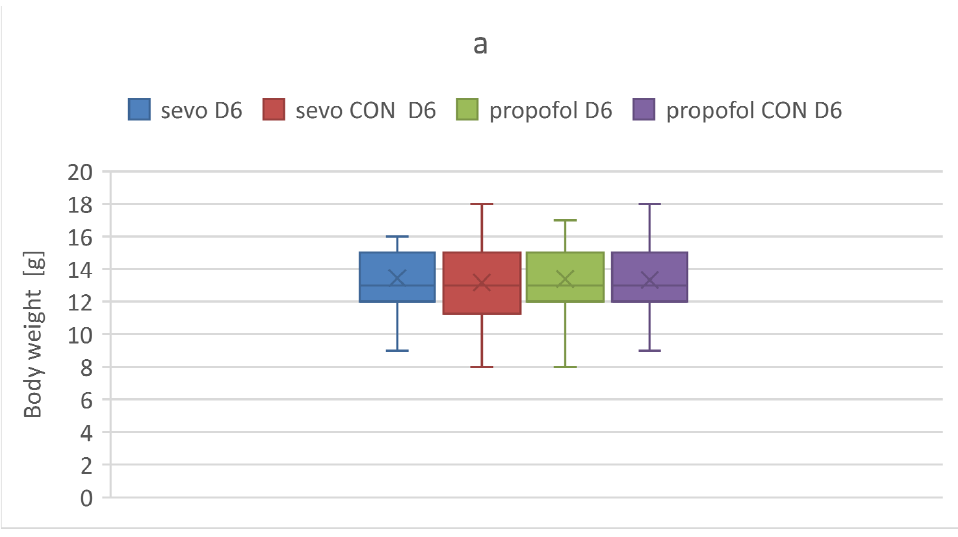
Figure 2. Rats’ body weight at D6, D30, D 60. Mean body weight [g] in the studied groups at D6, D30 and D60: sevo D6—mean body weight in the group of rats randomized to sevoflurane anesthesia; propofol D6—mean body weight in the group of rats randomized to propofol anesthesia; sevo CON D6; propofol CON D6—mean body weight in the groups randomized to control. Crosses represent mean. Whiskers represent standard deviation. Dots represent outliers. Boxes represent interquartile range. Horizontal lines represent medians. Data were checked for normality with the Shapiro-Wilk test. One-way ANOVA was used for multiple comparison with post hoc Bonferroni test. * p < 0.05 was assumed as statistically significant.